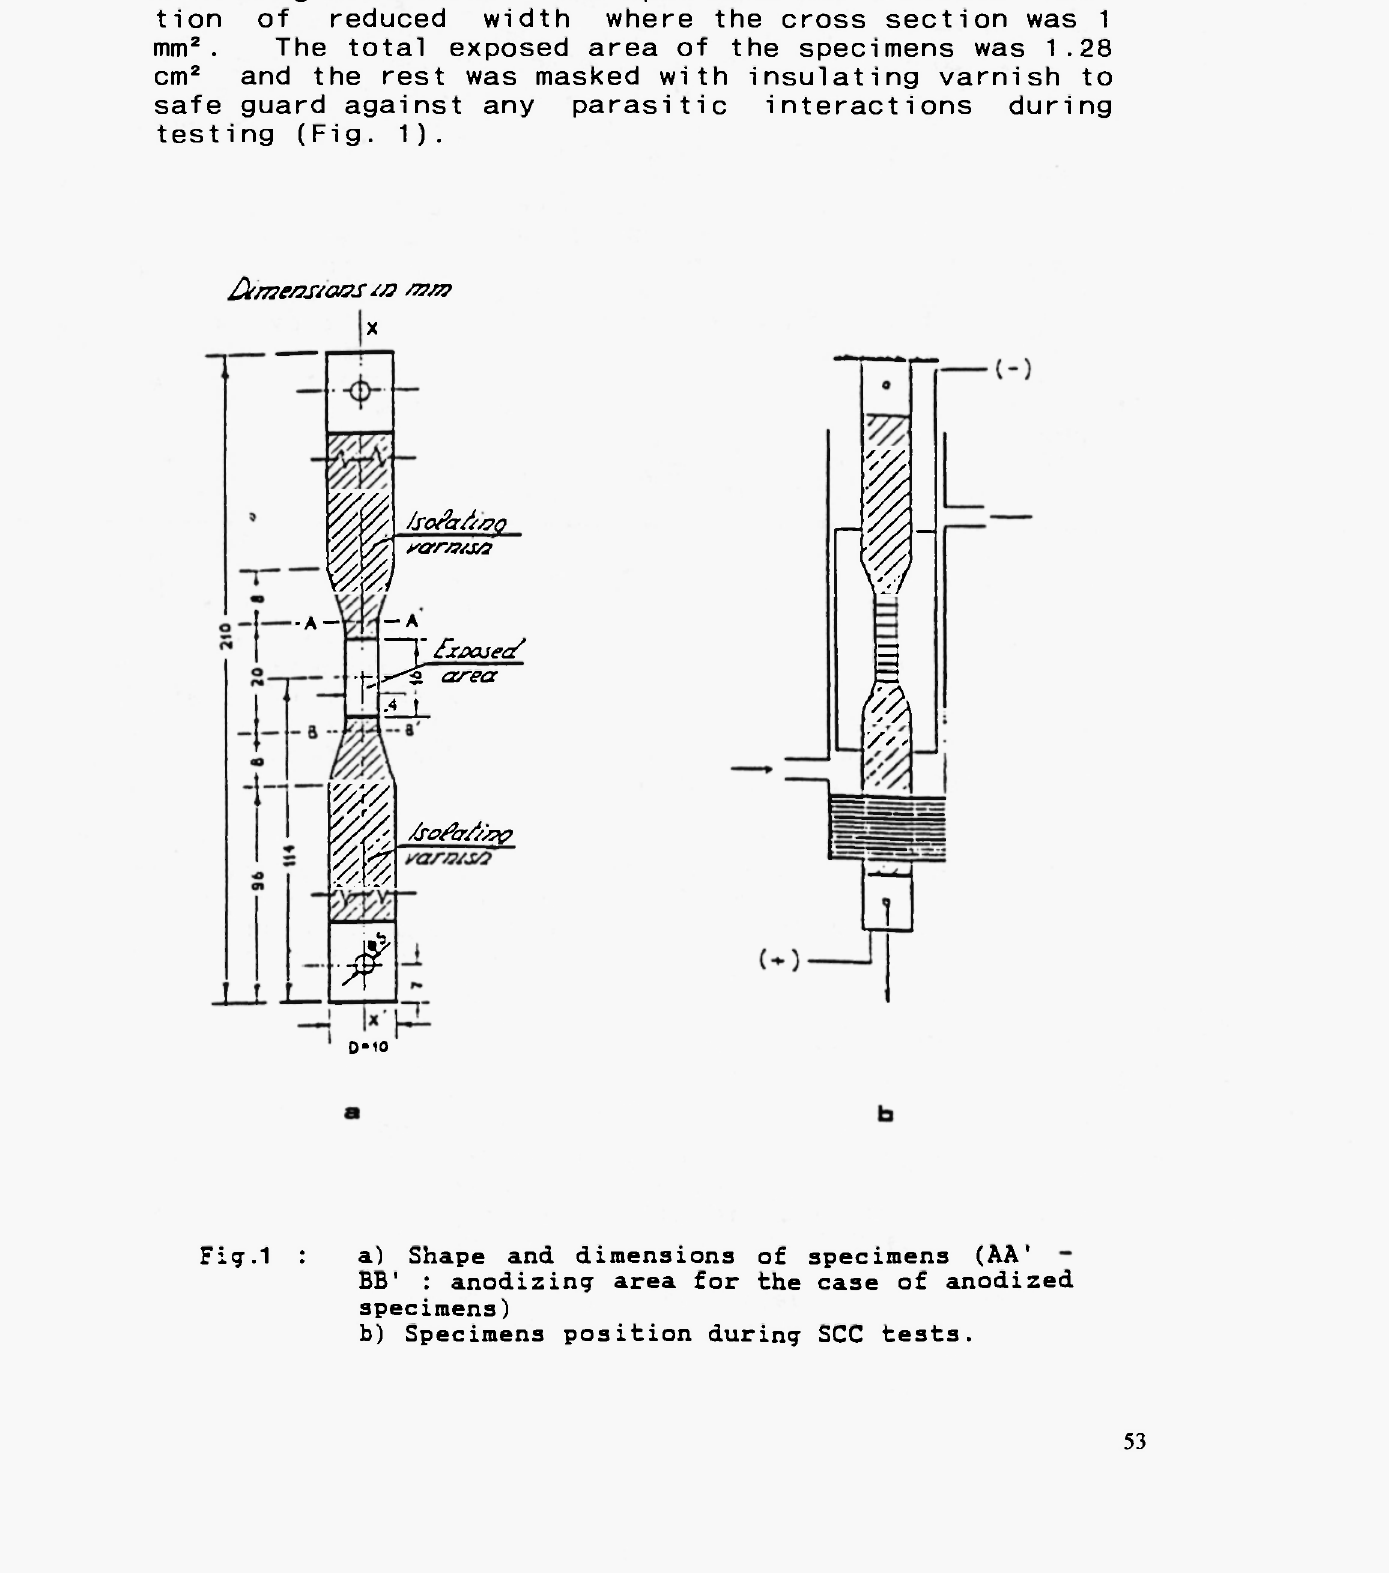
: a) Shape and dimensions of specimens (AA' BB* : anodizing area for the case of anodized specimens) b) Specimens position during SCC